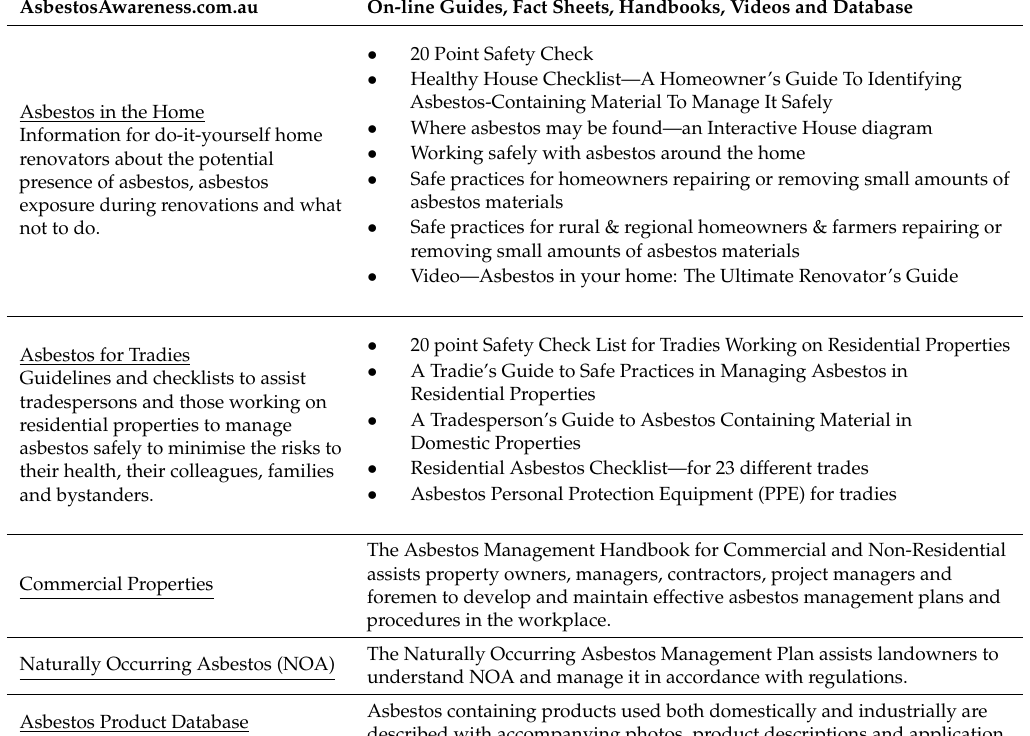
Table 1. On-line guides, fact sheets, handbooks, videos and database (Australian asbestos awareness resources available from the website